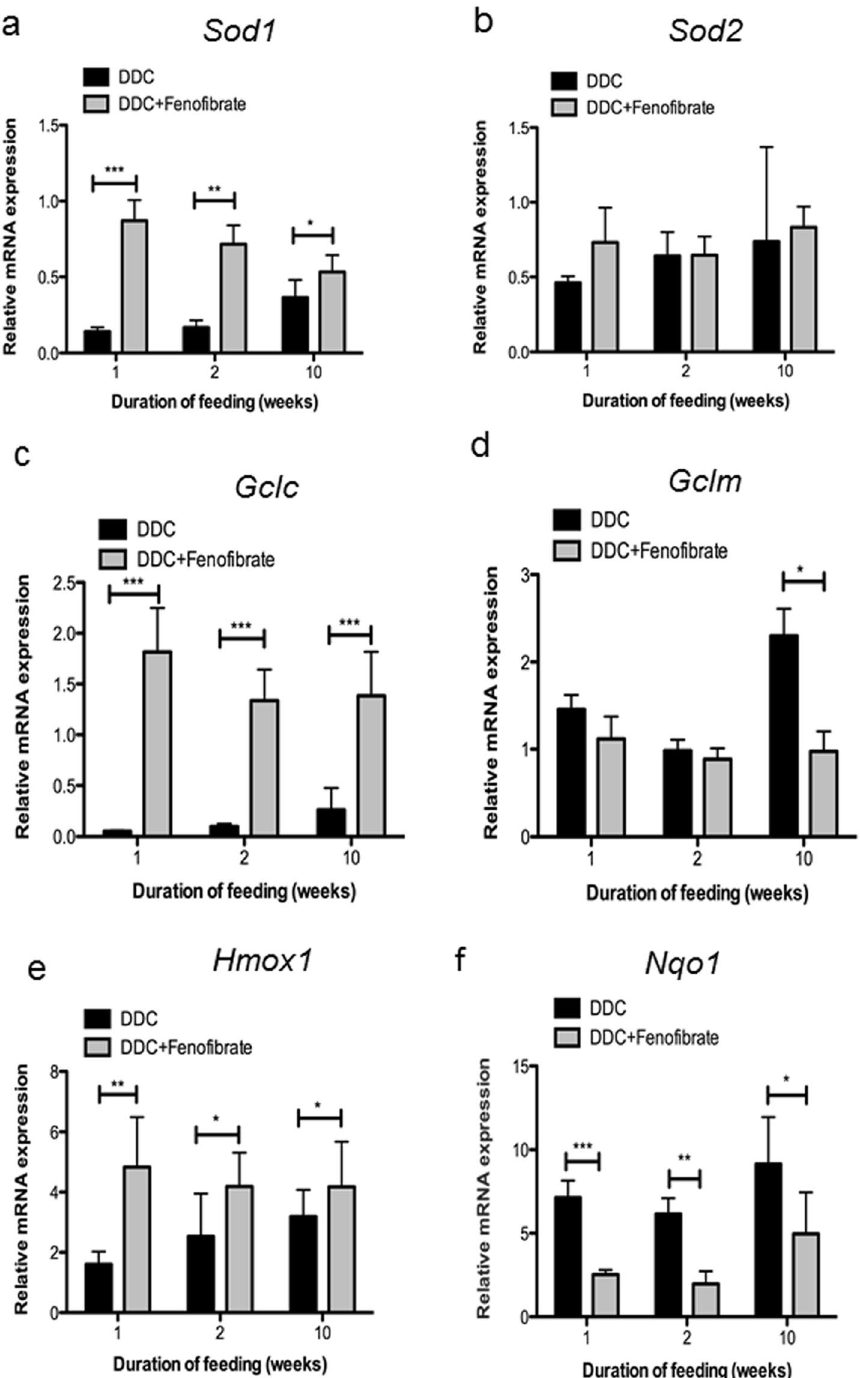
Figure 5. Effect of DDC/fenofibrate co-treatment on expression levels of antioxidant and stress–response genes. Normalized expression levels of ( a ) superoxide dismutase 1 ( Sod1) , ( b ) superoxide dismutase 2 ( Sod2) , ( c ) glutamate-cysteine ligase, catalytic subunit ( Gclc) , ( d ) glutamate-cysteine ligase, modifier subunit ( Gclm) , ( e ) heme oxygenase 1 ( Hmox1) , and ( f ) NAD(P)H dehydrogenase quinone 1 ( Nqo1) were evaluated by qRT-PCR of mRNA extracted from whole liver tissue. Data are given as fold-change relative to controls represented as mean ± SD collected from five animals per treatment group. Significances of DDC intoxication stages are shown versus co-administration of DDC and fenofibrate: * p < 0.05; ** p < 0.01; *** p <